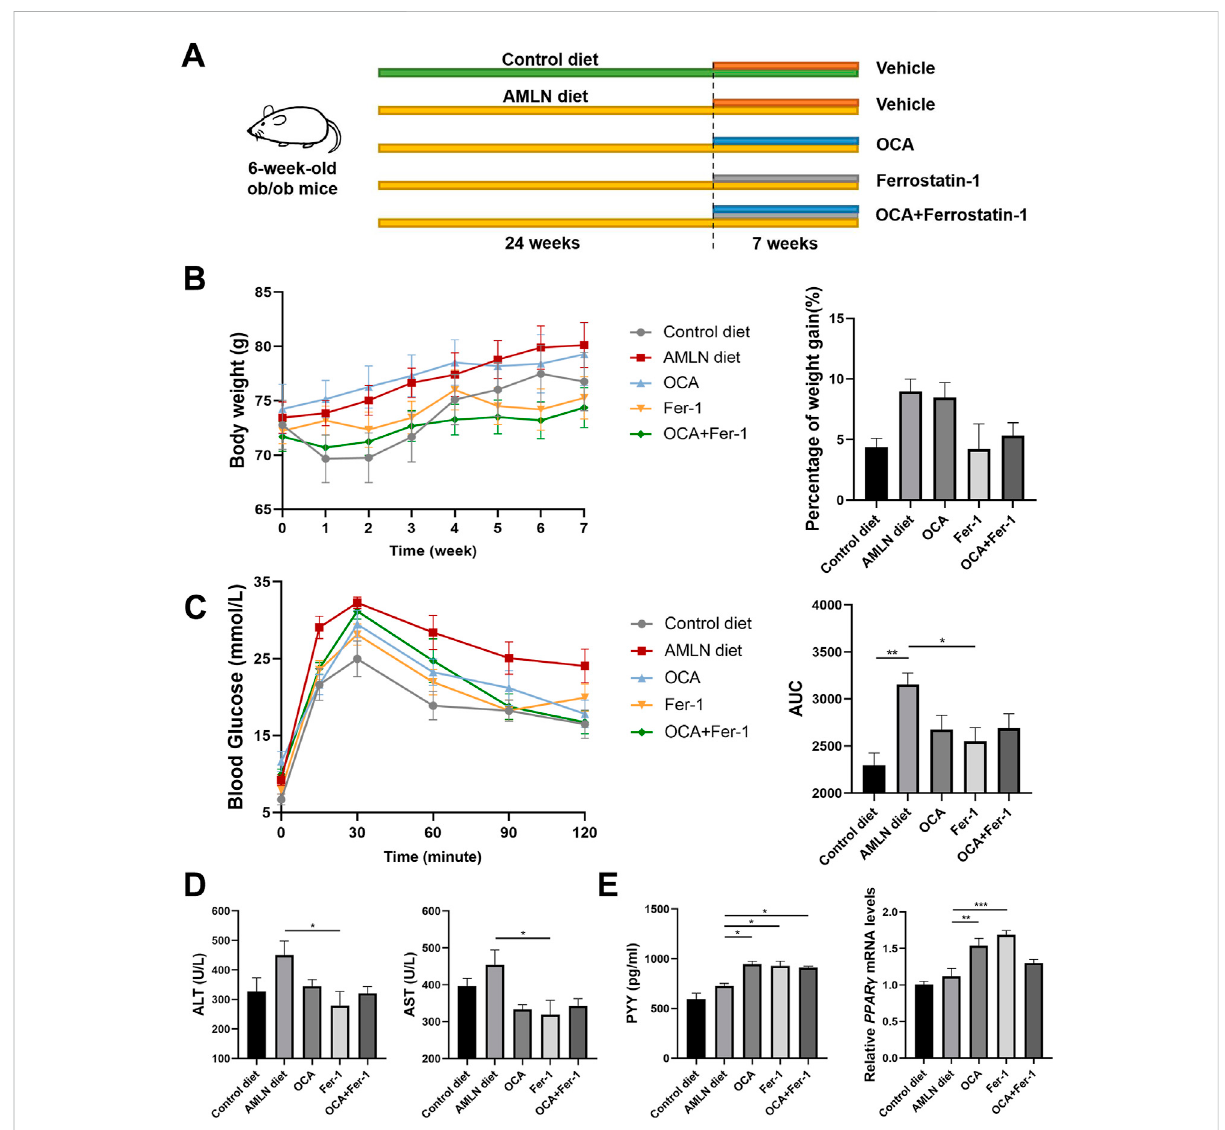
Fer-1 exhibited better effects on improving metabolic status than OCA in AMLN diet induced NASH mice. (A) Experimental scheme. (B) Body weight after treatments (left) and the percentage of weight gain after treatments (right). (C) Blood glucose (left) and area under the curve (right) of IGTT. (D) Liverfunctiontestsofserum(ALTandAST). (E) LevelsofPYYintheliver(left)andrelativeexpressionof PPAR γ inlivertissues.Dataareshown as mean ± SEM. * p < 0.05, ** p < 0.01, *** p <